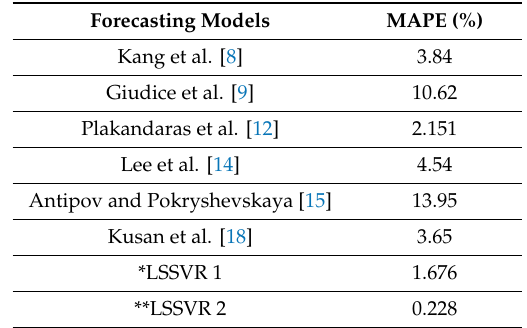
Table 5. A list of MAPE values of previous studies and this